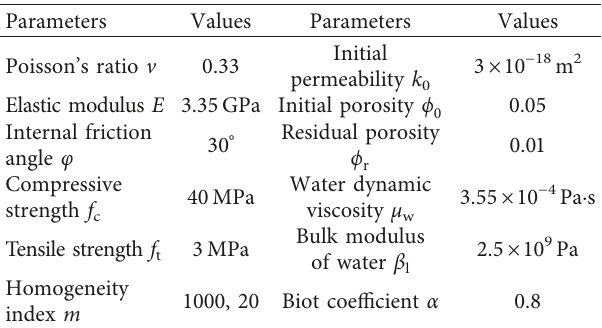
Figure 6: Definite and geometry conditions for numerical simulation. Table 2: Parameters of coal-rock mass and water for numerical